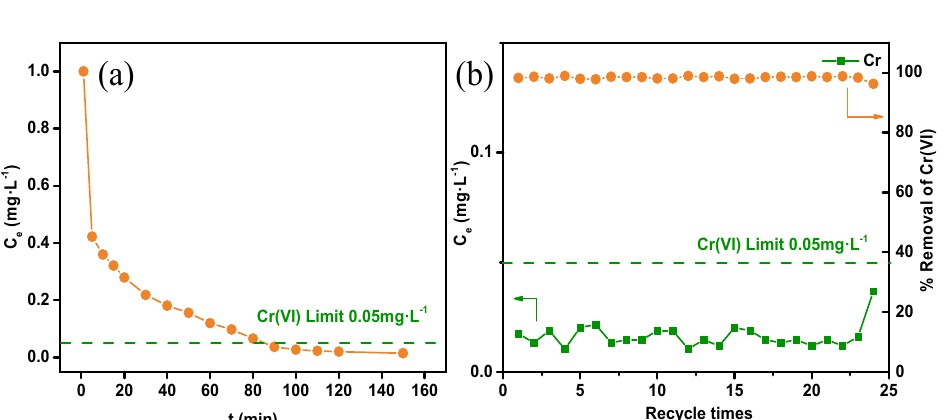
Figure 8. ( a ) Plots of the residual concentration against reaction time for the low-level removal of Cr(VI); ( b ) residual concentration of Cr (VI) in solution and the removal efficiency of the DAPFP biosorbent.